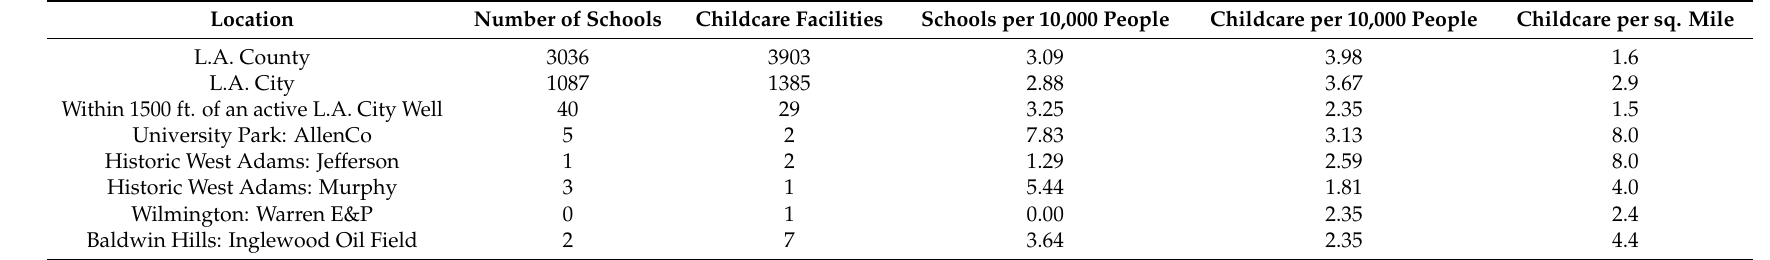
Table 1. Sensitive land uses in selected areas hosting oil production